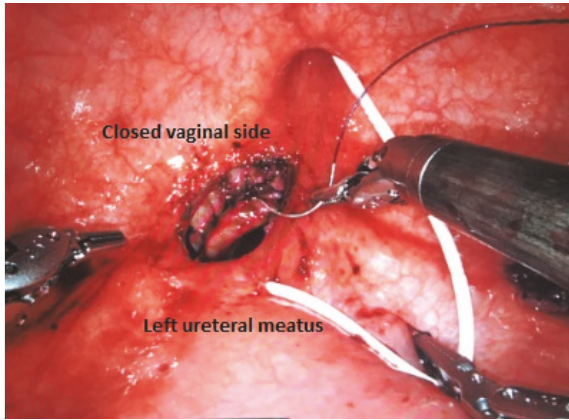
Figure 5: Vaginal side sutured by 3-0 barbed suture in 2 layers.